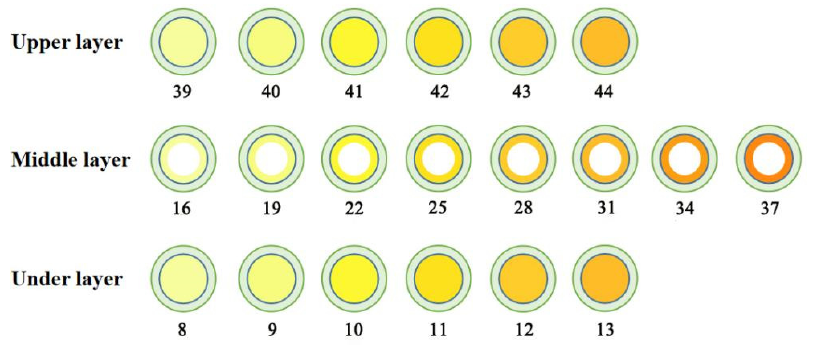
Figure 3. Three-layer nested structure model with PN layer single-layer section diagram.